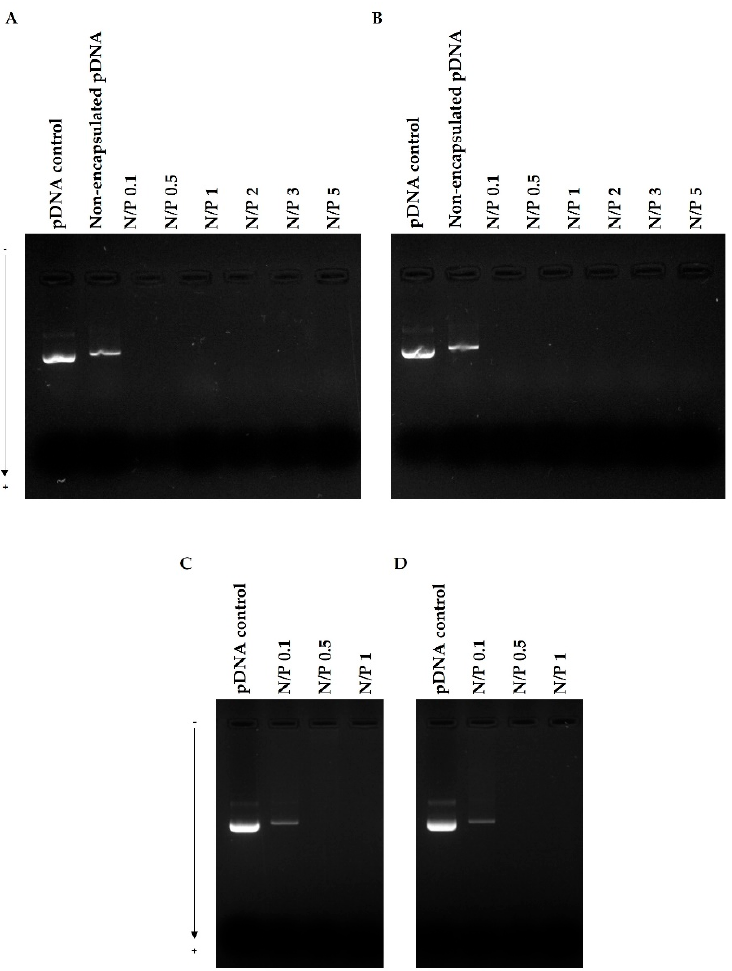
Figure 2. WRAP5/pDNA ( A ), Tf-WRAP5/pDNA ( B ), TMZ/WRAP5/pDNA ( C ), and TMZ/Tf- WRAP5/pDNA ( D ) complexation behavior at various N/P ratios investigated by agarose gel elec- trophoresis. The complexes were formulated, centrifugated, and the supernatants containing the potential free pDNA were loaded on the agarose gel (See Scheme S1A). Lane 1: pDNA control sam- ple.